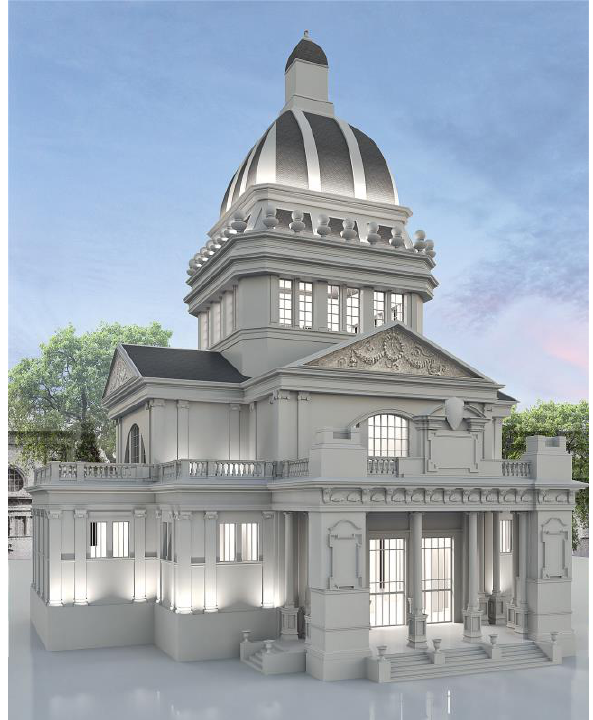
Figure 11. Final 3D model of the Pavilion of the City of Turin